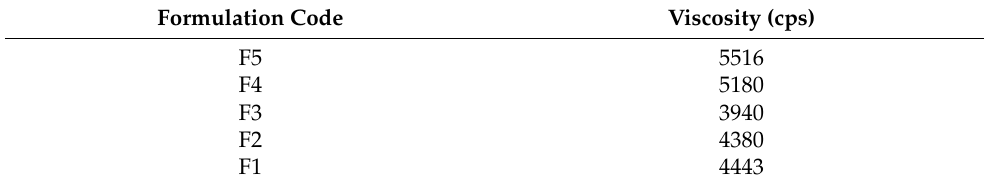
Table 3. Viscosity of all formulations at 25 ◦ C.